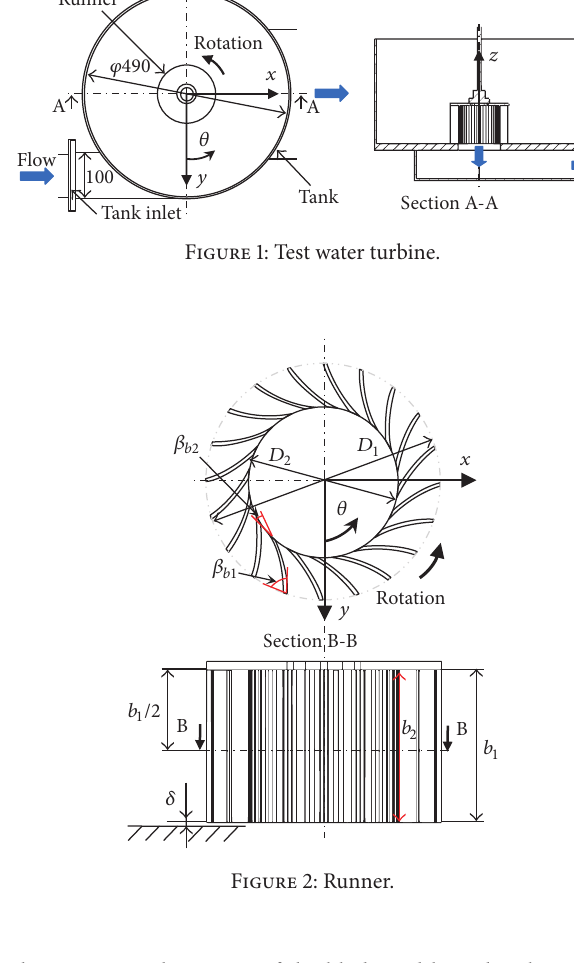
Table 1: Specifications of runner.